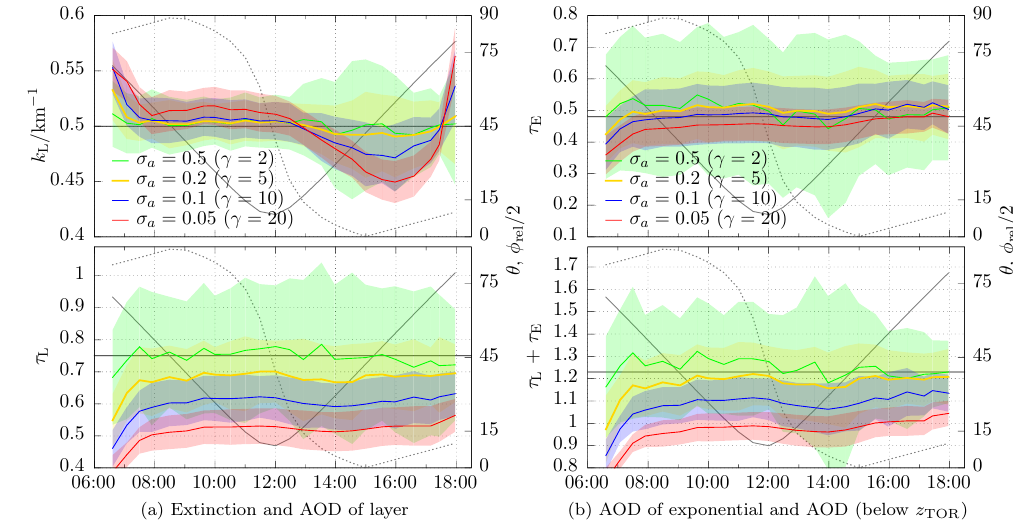
(Table 1). Lines indicate averages of 100 samples, 0